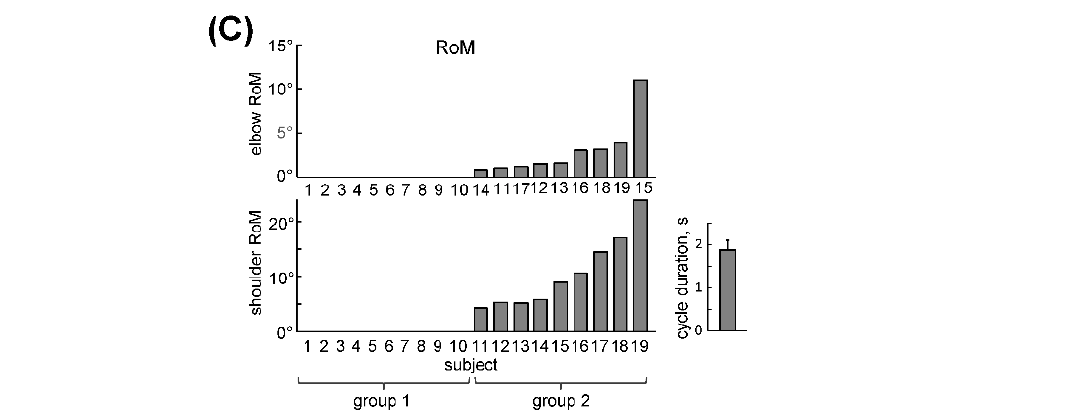
Figure 1. General characteristics of non-voluntary rhythmic upper limb movements. ( A )—experi- mental setup for investigating arm rhythmic movements and their relationship with the relative excitability of alpha motoneurons to excitatory inputs from Ia afferents (H-reflex). Muscle vibration was used to evoke non-voluntary limb oscillations while electrical stimulation (ES) of the median nerve was used to evoke the H-reflex. The legs and the right arm were stationary. ( B )—examples of changes in limb kinematics and EMG activity in response to continuous TB (triceps brachii) vibra- tion in two subjects. BB—biceps brachii, TB—triceps brachii, DA—deltoideus anterior portion, DP— deltoideus posterior portion. Right panels show stick diagrams of upper limb oscillations. Note the absence of limb movements in subject 5 and their appearance in subject 19. ( C )—range of angular motion (ROM) of evoked elbow and shoulder joint oscillations in all individual subjects (ordered by the magnitude of the ROM in the shoulder joint). The subjects were divided into two groups: with and without rhythmic arm movements (groups 2 and 1, respectively). Cycle duration (mean + SE) of evoked movements is also shown for group 2 (right panel).